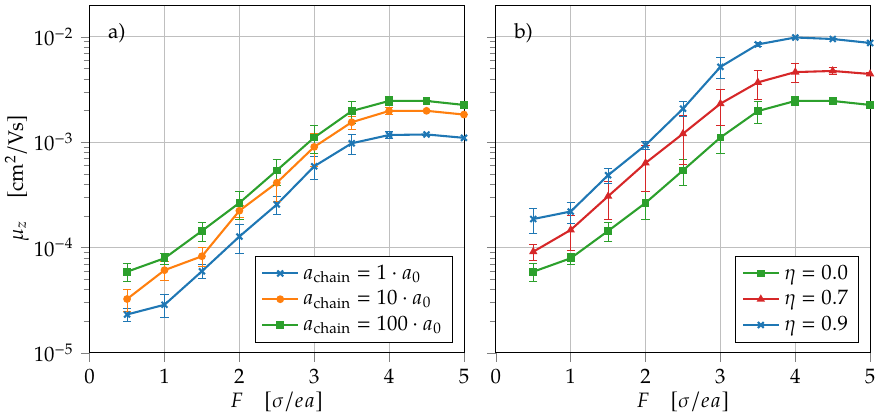
Figure 7. Carrier mobility µ versus electric field F for different morphologies with chain length l c = 20nm. ( a ) Fixed morphology with Gaussian chains η = 0 and varying a chain for intrachain transport; ( b ) morphologies with varying orientation for fixed a chain = 100